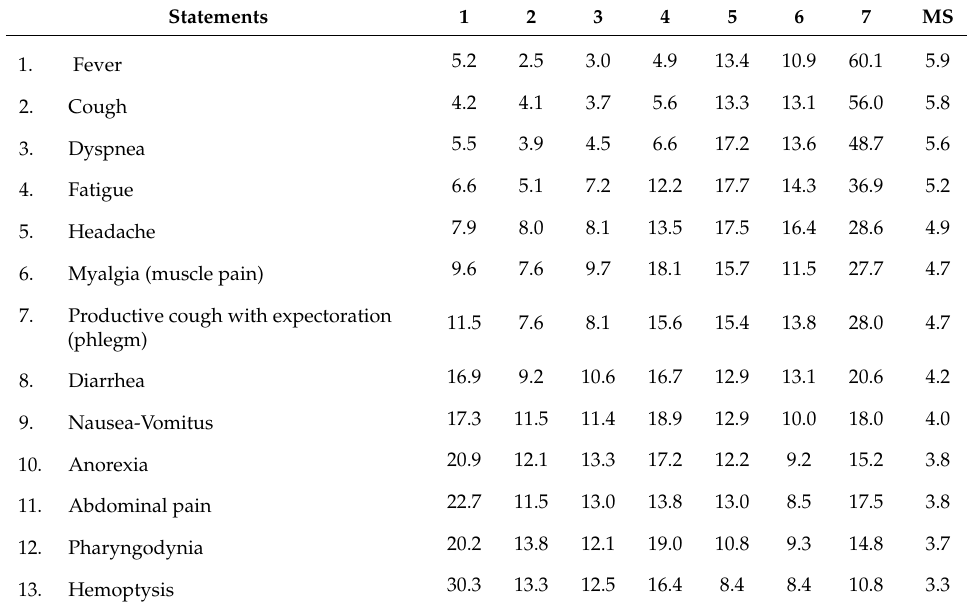
Table 3. Gen Z’ers self-reported knowledge of 13 specific COVID-19 symptoms (%).